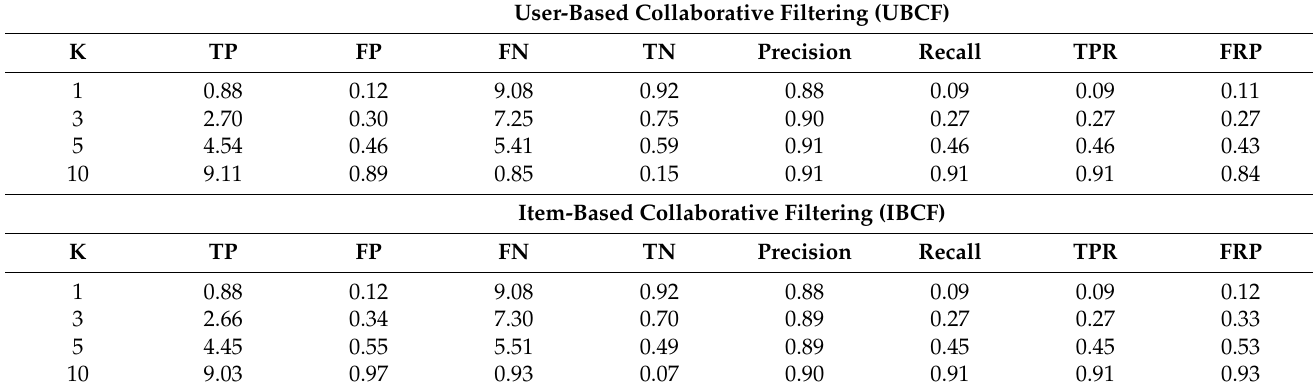
Table 3. Confusion matrix by model, Brazilian Longitudinal Study of Adult Health (ELSA-Brasil),